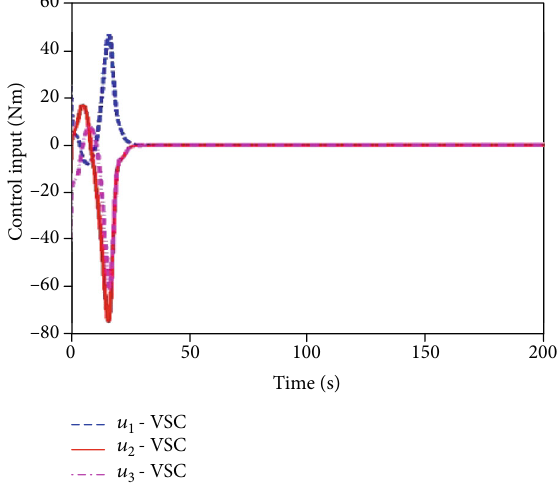
Figure 16: Time histories of attitude quaternions in Case 3 when k ð 0 Þ = 0 : 5 .